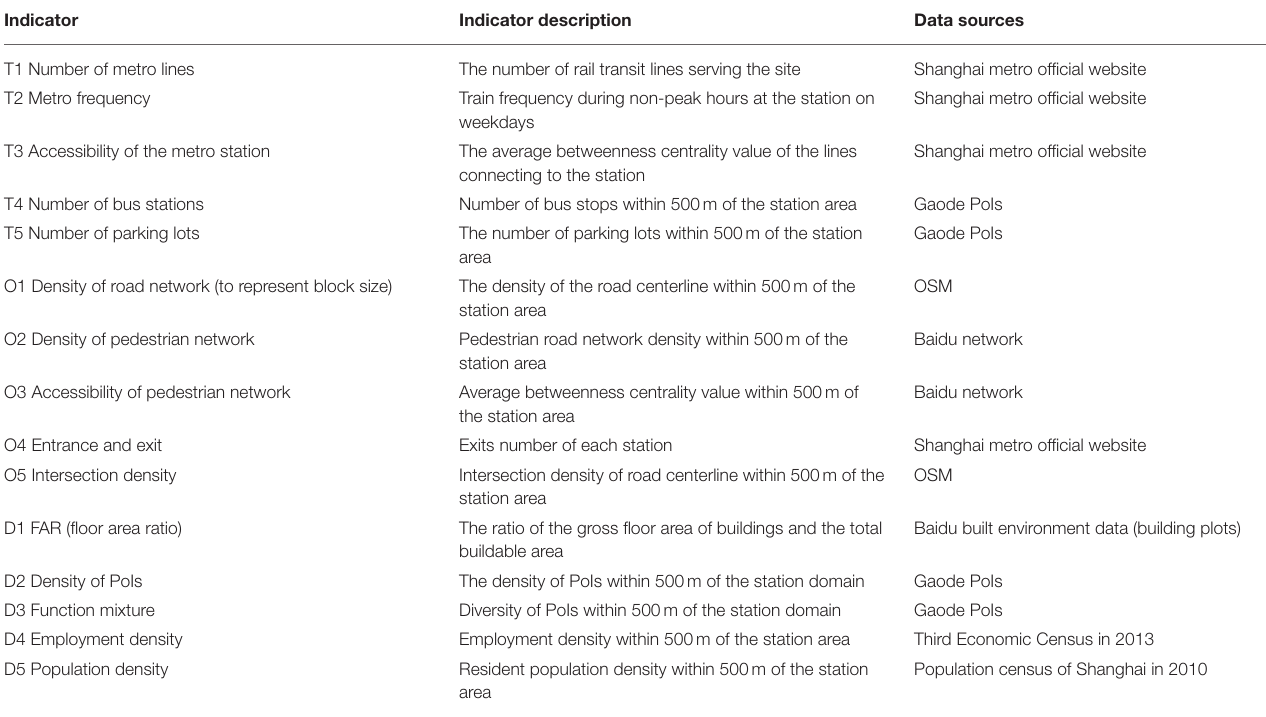
TABLE 2 | Overview of